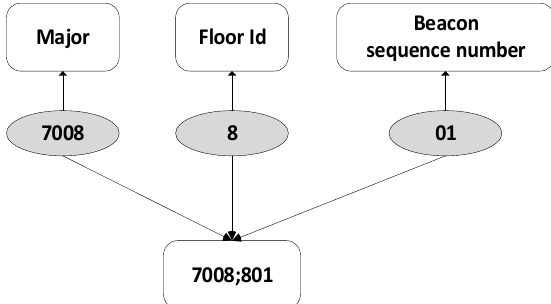
Figure 4. Example of a BLE beacon identifier used in the proposed indoor positioning